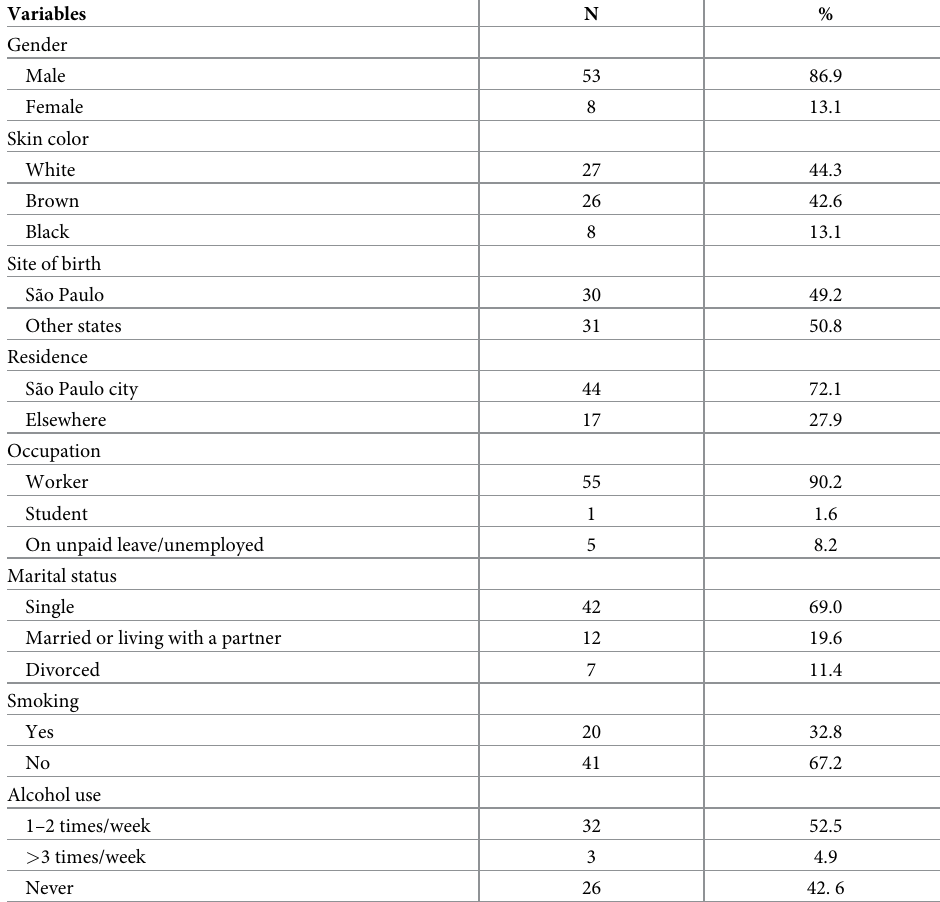
Table 1. Socio-demographic profile, smoking and alcohol use in the study